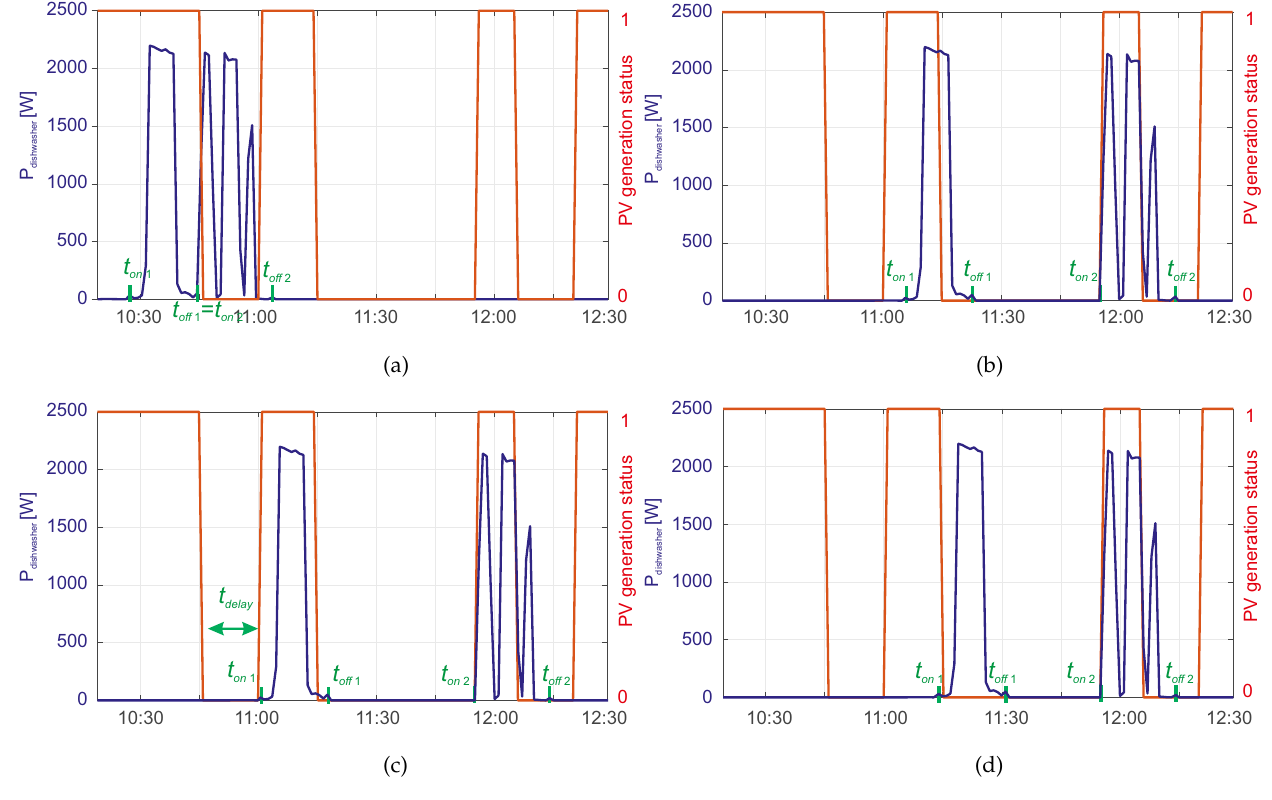
Figure 9. Examples of dishwasher operation with a pause in its operation due to the EEM algorithm: ( a ) without a pause in operation, ( b ) without a delay in switching on and with a pause in operation, ( c ) with a delay in switching on and with a pause in operation, ( d ) without a delay in switching on and with a pause in operation. The moment of switching on occurs just before the end of the PV generation.